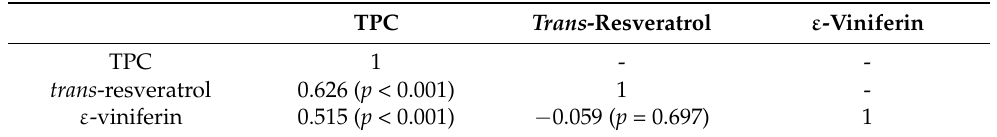
Table 6. The Pearson’s correlation coefficients between the TPC, trans -resveratrol, and ε -viniferin in 23 vine shoot